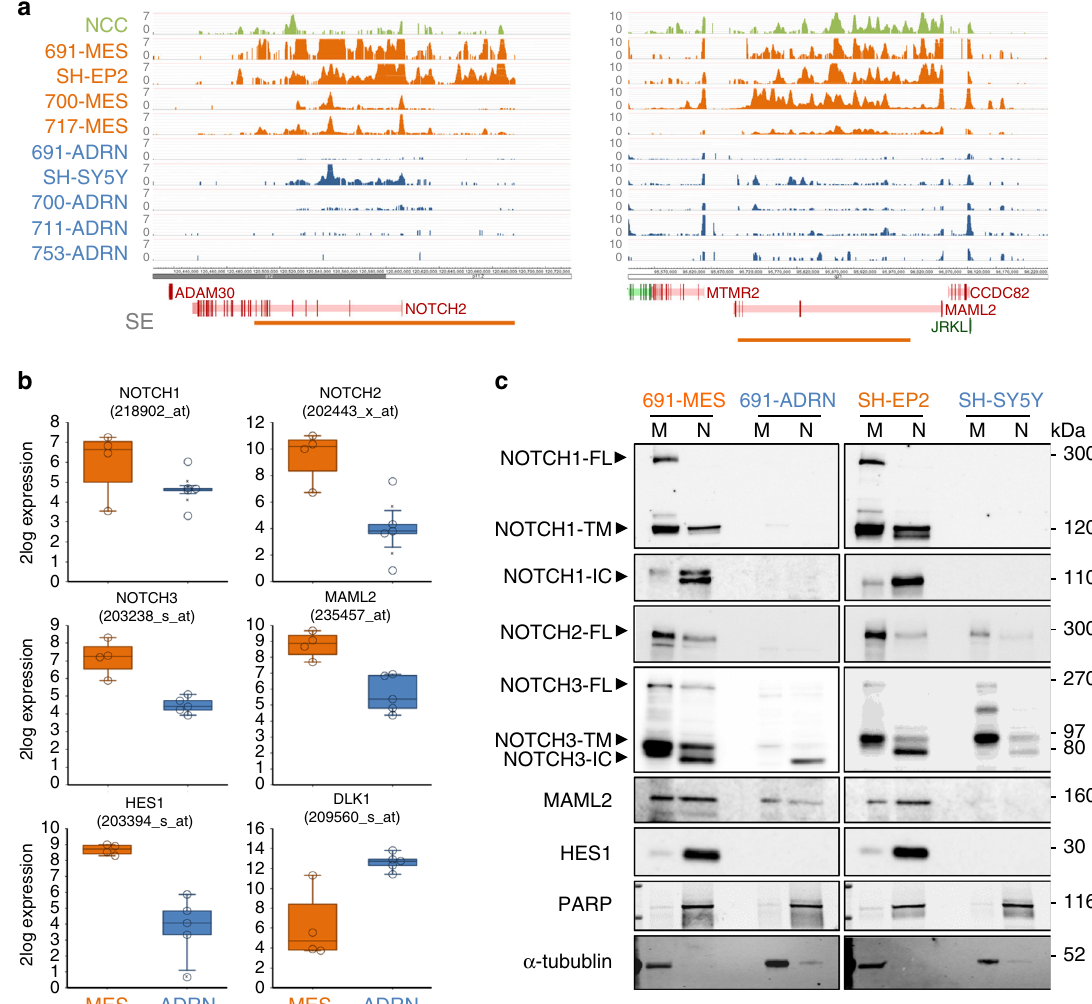
Fig. 1 The core regulatory circuitry of MES cells includes transcription and activation of the NOTCH pathway. a ChIP-sequencing pro fi les of H3K27ac mark in neural crest cells (NCC, in green), MES neuroblastoma cells (691-MES, SH-EP2, 700-MES, 717-MES, in orange) or ADRN neuroblastoma cells (691- ADRN, SH-SY5Y, 700-ADRN, 711-ADRN, 753-ADRN, in blue). The number of reads per 20 million mapped reads is shown on the y -axis. Chromosomal gene position is shown on the x -axis. Super-enhancers (SE) are indicated by horizontal bars. Gene color depicts orientation on sense (green) and anti- sense (red) DNA strands. b Box plots of mRNA expression for the four MES cell lines and fi ve ADRN cell lines shown in panel a . Whiskers denote the interval within 1.5 times the interquartile range (box edges) of the median (center line). Expression values (2log-transformed) for each cell line are indicated by open circles. Affymetrix mRNA probesets are indicated for each gene. c Western blot analysis of NOTCH1, NOTCH2, NOTCH3, the NOTCH co-factor MAML2 and the NOTCH target gene HES1 in membrane (M) or nuclear (N) lysates. Protein lysates were from MES- and ADRN cell line pairs of isogenic origin, depicted in orange and blue, respectively. IC intracellular domain, FL full-length, TM transmembrane. PARP and α -tubulin were used as loading controls for the nuclear- and membrane fractions, respectively. Source data are provided as a Source Data fi